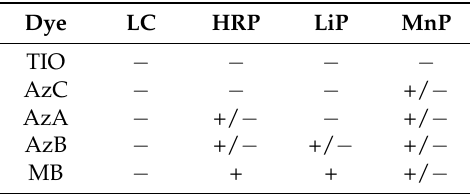
Table 1. Enzymatic bleaching of the tested dyes. Legend: LC laccase, HRP horseradish peroxidase,